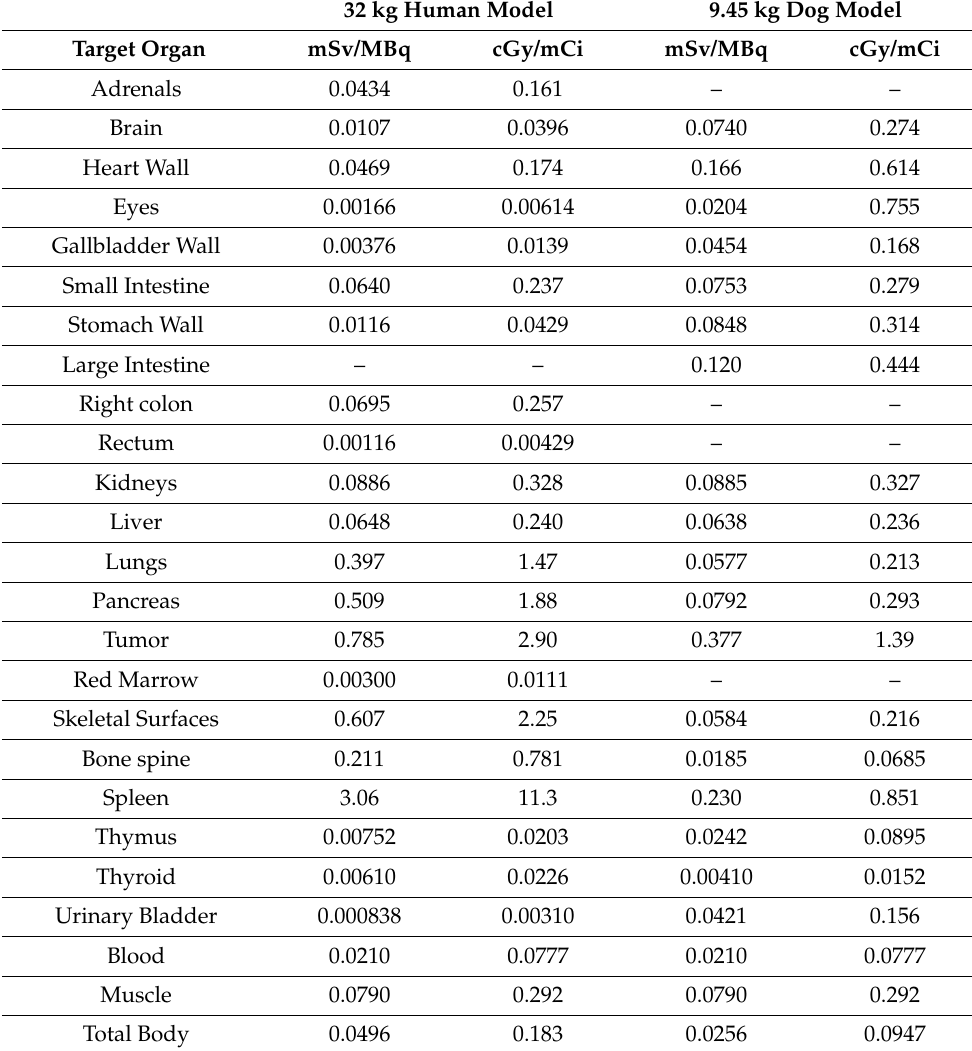
Table 1. Radiation doses which would be delivered by 177 Lu-IF3 mAb to the OS tumor and major organs in a 32 kg 10-year-old female child and a 9.45 kg